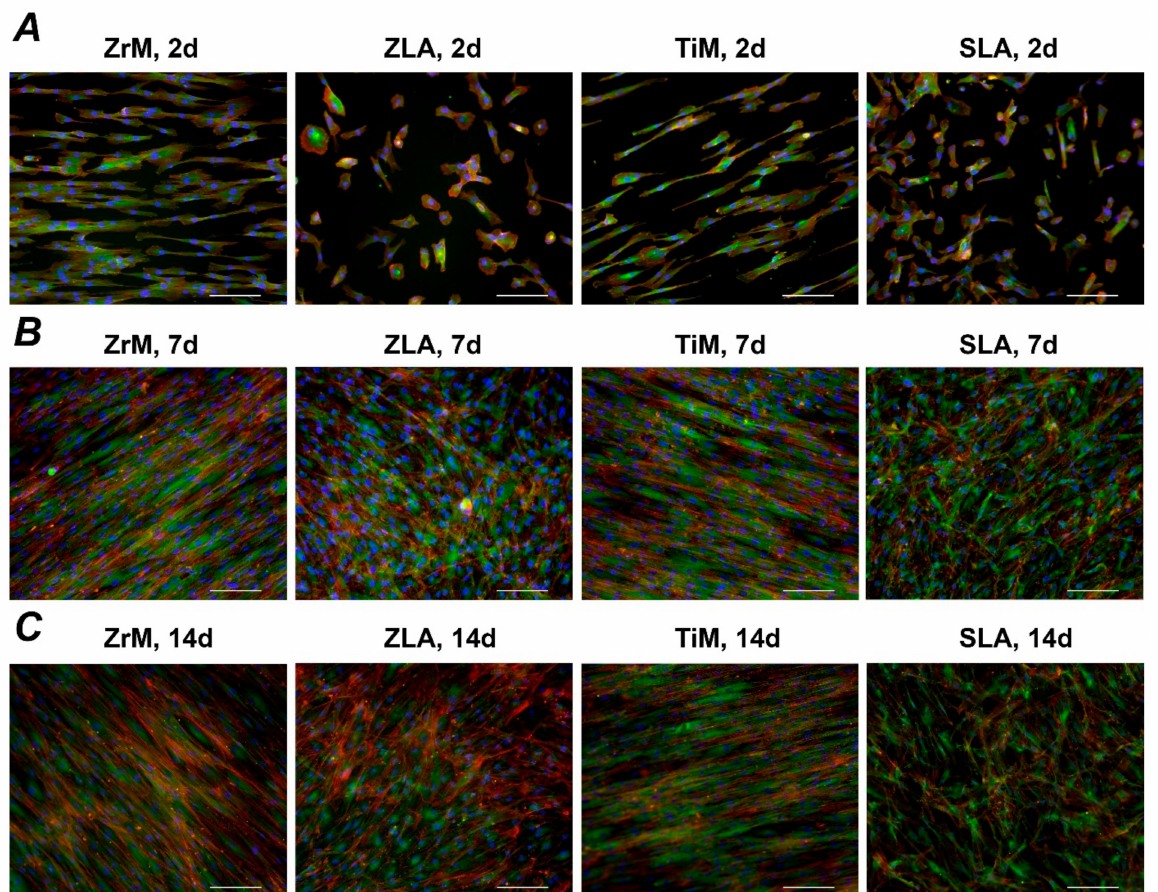
Figure 3. Fluorescence microscopy images of primary hGFs cultured on a smooth machined ZrO 2 surface (ZrM); a moderately rough ZrO 2 surface (ZLA); smooth machined Ti surface (TiM); a moderately rough, sand-blasted, large grain acid-etched Ti surface (SLA). Cell culture was performed for 2 ( A ), 7 ( B ), and 14 ( C ) days; F-actin was stained with TRITC- conjugated Phalloidin (red), focal adhesions with anti-Vinculin visualized by fluorescein isothiocyanate (FITC) (green), and the nucleus with 40,6-Diamidin-2-phenylindol (DAPI) (blue). Scale bars correspond to 100 µ